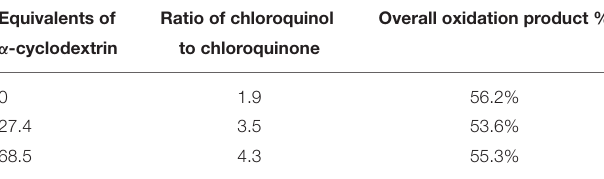
TABLE 1 | Effects of α -cyclodextrin addition on the distribution of decomposition products obtained from chlorine dioxide treatment of bisphenol A a . Equivalents of Ratio of